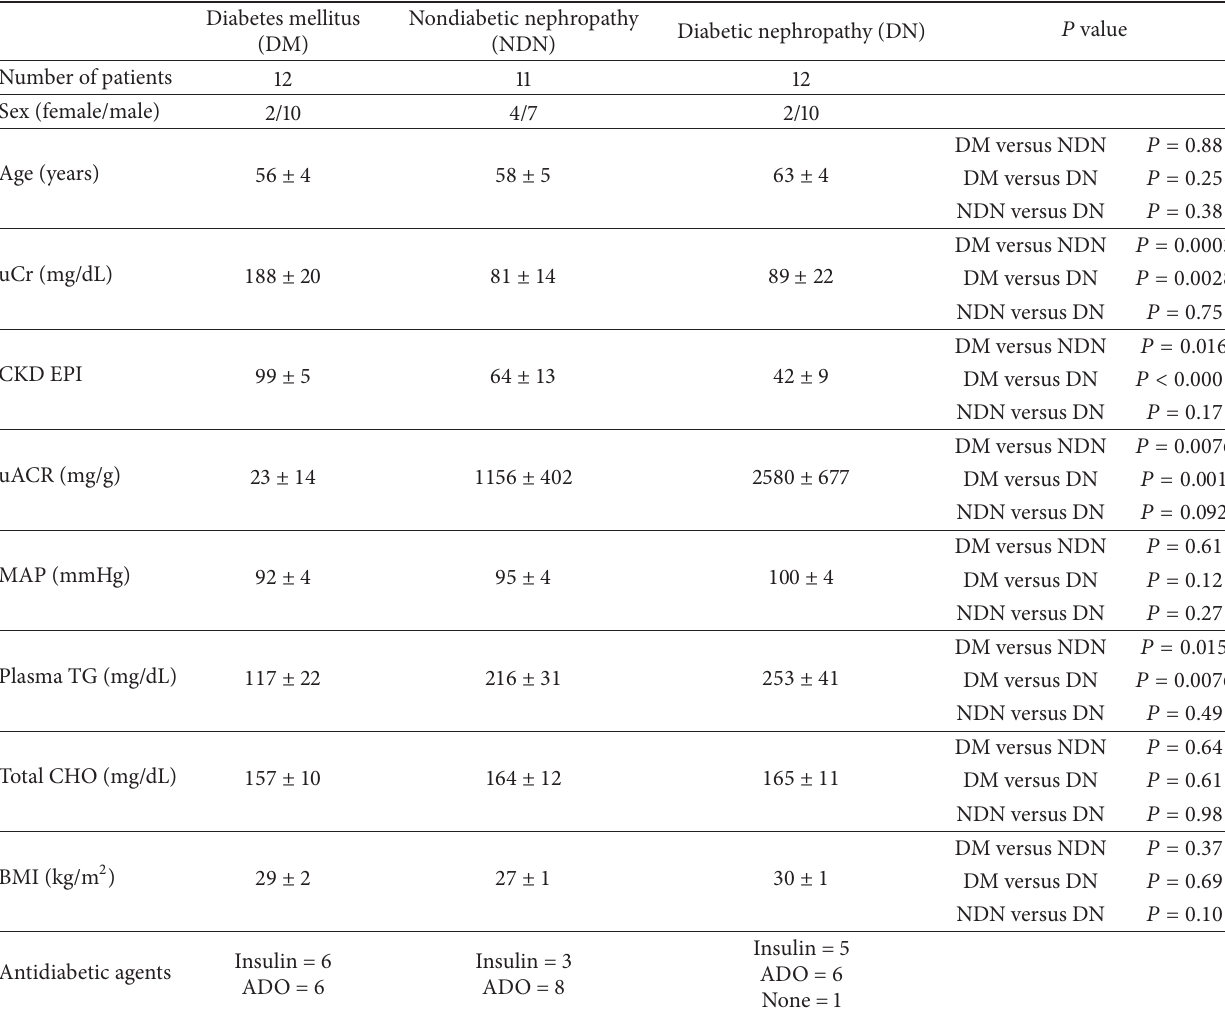
Table 1: Demographic and clinical characteristics of 12 diabetic patients (DM), 11 diabetic patients with nondiabetic nephropathy (NDN), and 12 patients with diabetic nephropathy (DN). Data are expressed as the mean ± standard error of the mean (SEM). Statistical analysis was performed using one-way ANOVA followed by Newman-Keuls multiple comparison test. 𝑃 values < 0.05 were considered statistically